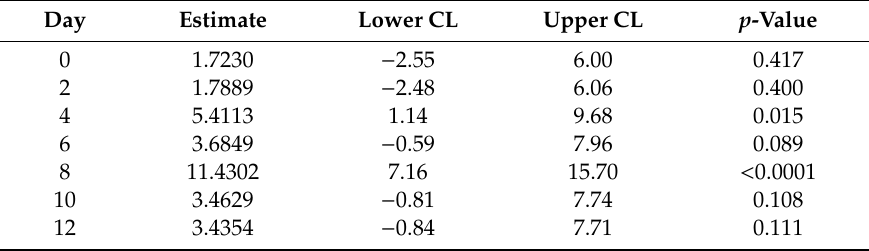
Table 3. Di ff erence between 0-dose and low-dose groups in least square means of NES RNA expression according to day.